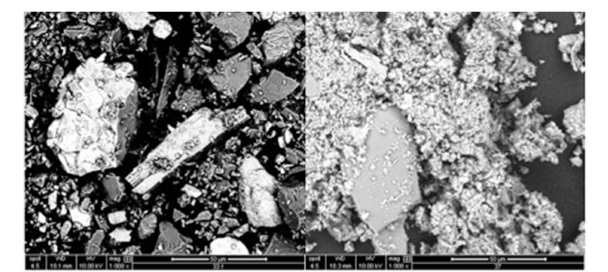
FIGURE 8 | SEM image of sediment collected from ice within Godthåbsfjord (collected within 500m of station GF 11). Particles collected from melting part of an iceberg (left) and from ice mélange (right) .